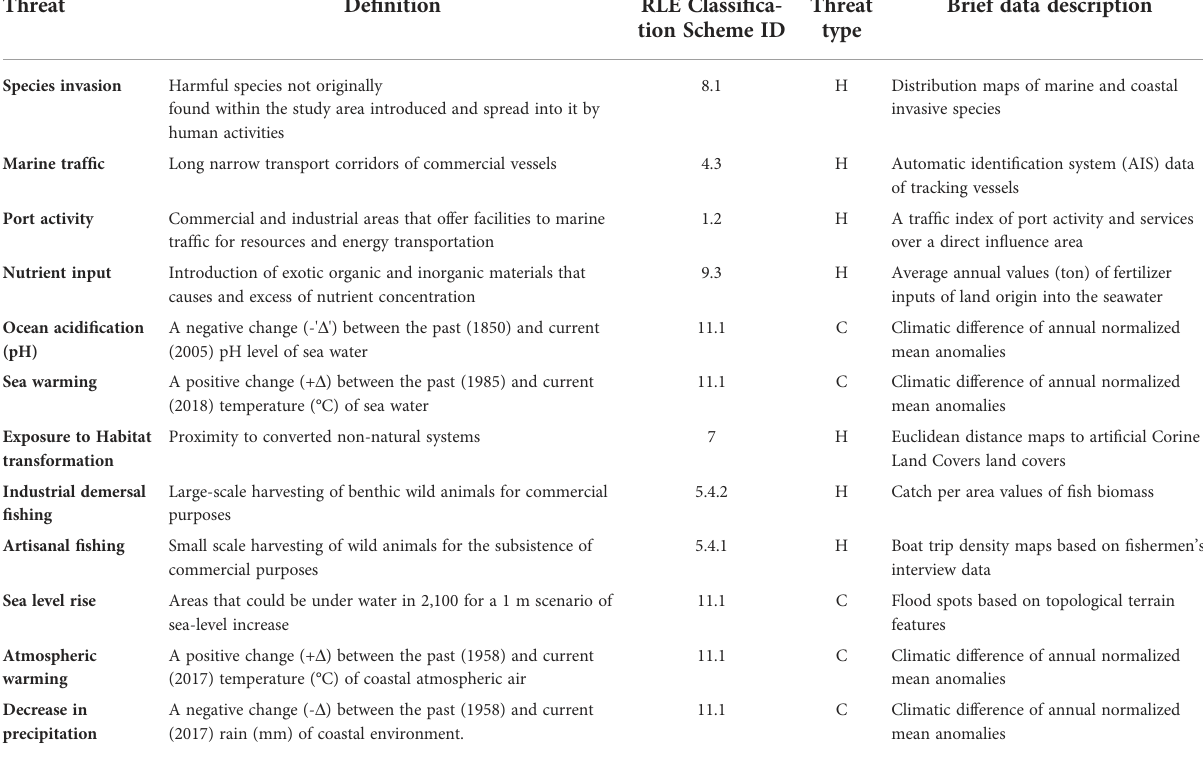
TABLE 2 Descriptions of the 12 chosen threats.